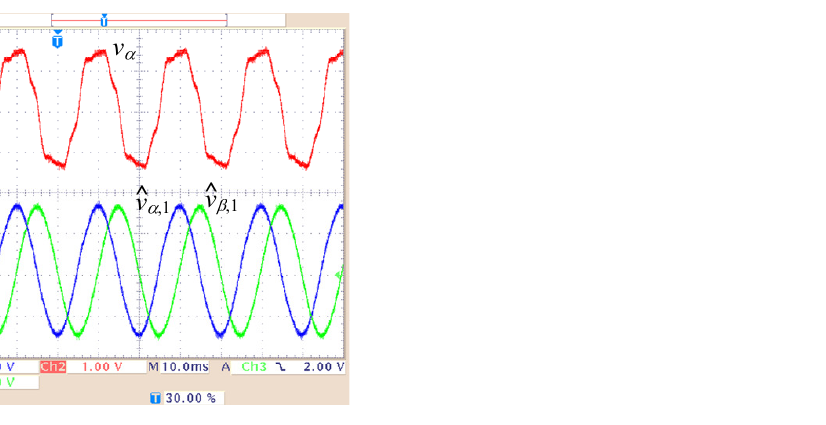
Figure 6. Steady state responses of the proposed SOHO-based FLL at f 0 = 50 Hz of ( top ) v α , and ( bottom ) ˆ v α ,1 and ˆ v β ,1 ( x -axis: 10 ms/div; y -axis: 200 V/div).